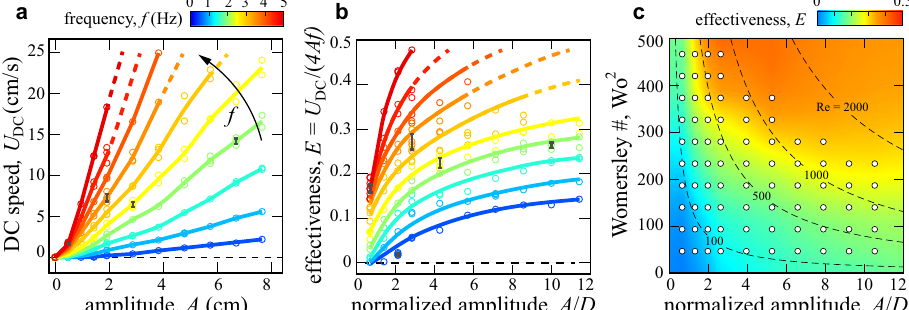
Fig. 6 Performance of the fl uidic AC-to-DC converter or pump. a Average DC fl ow speed U DC versus driving amplitude A and at different frequencies f . Representative error bars (black) show standard errors of the mean. b Effectiveness of recti fi cation versus amplitude normalized by the hydraulic diameter D . c Experimentally measured effectiveness. The axes correspond to normalized amplitude and non-dimensional frequency or Womersley number Wo 2 ∝ f . White markers indicate data points, and the colormap is interpolated and extrapolated elsewhere. The dashed hyperbolic curves are contours of the driving or oscillatory Reynolds number Re / Wo 2 (cid:6) A = D